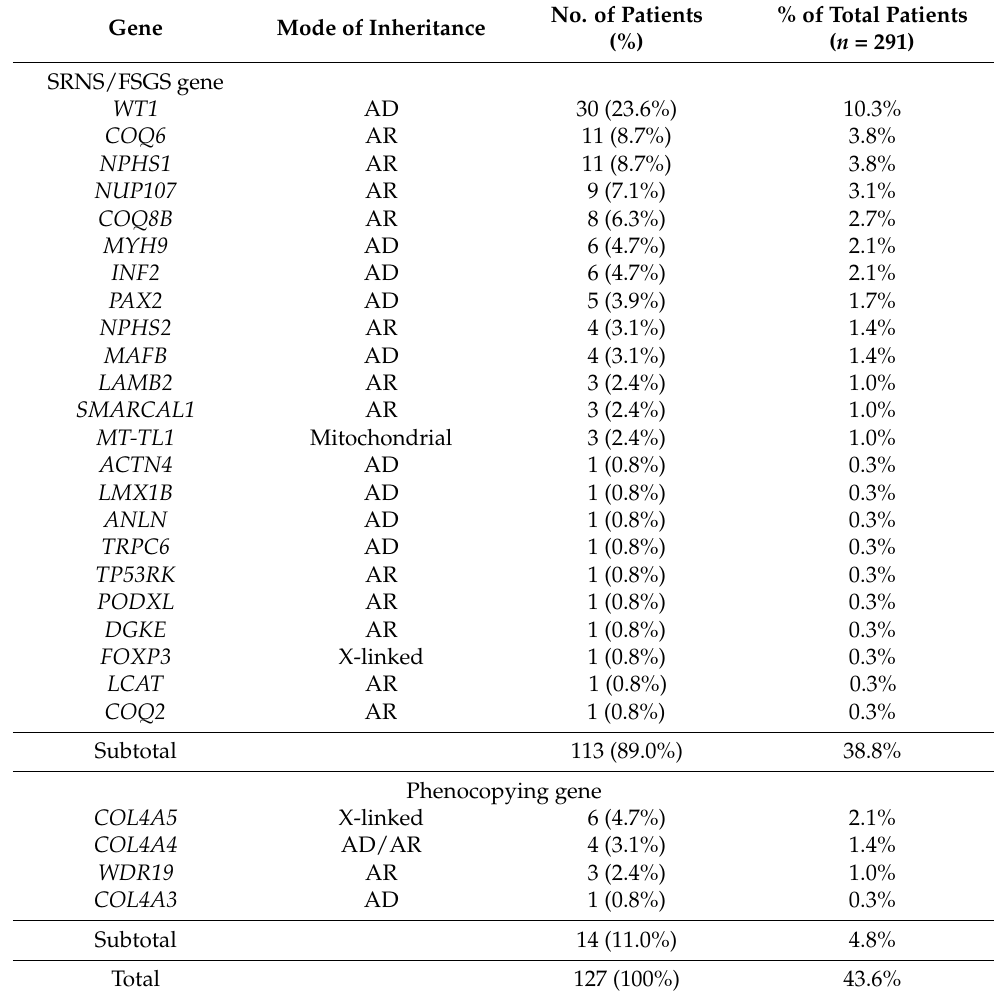
Table 2. Mutation screening